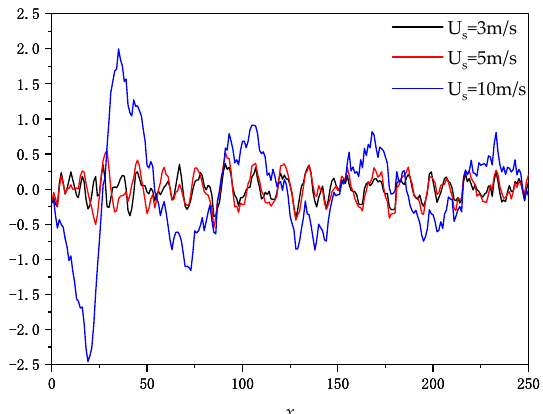
height and wavelength of the wake superimposed with the sea surface increase.